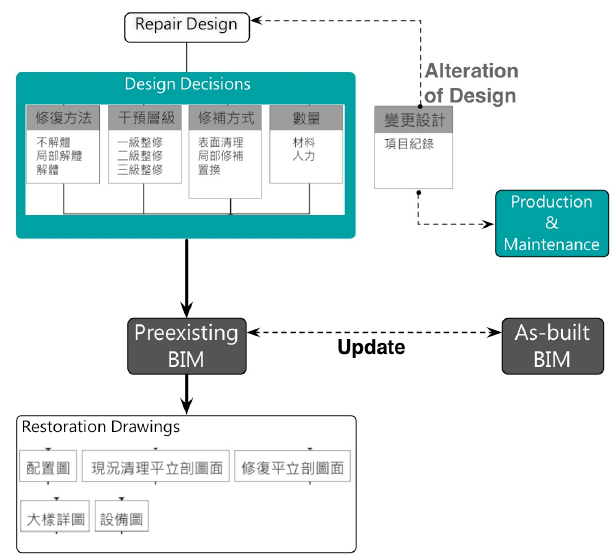
Figure 5. BIM modeling process in repair design